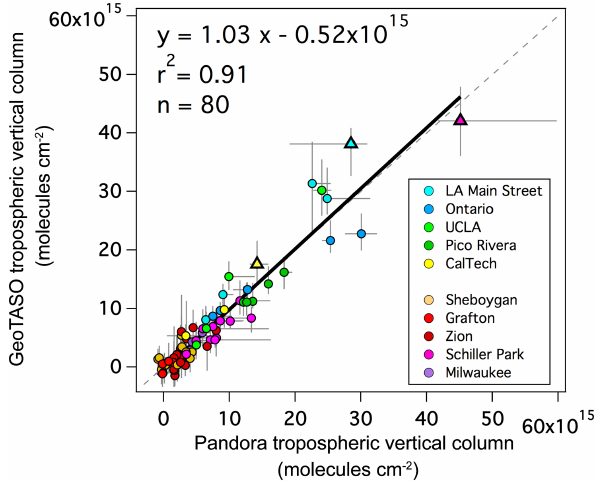
Figure 3. Scatter plot of GeoTASO NO 2 TropVCs vs. Pandora NO 2 TropVCs colored by Pandora site. Vertical whiskers show the 90th and 10th percentiles of GeoTASO TropVCs within the 750m ra- dius of the Pandora site. Horizontal whiskers show the maximum and minimum Pandora TropVCs within the ± 5min coincidence window. Triangles indicate coincidences discussed within Sect. 3.1. The gray dashed line indicates the 1 : 1